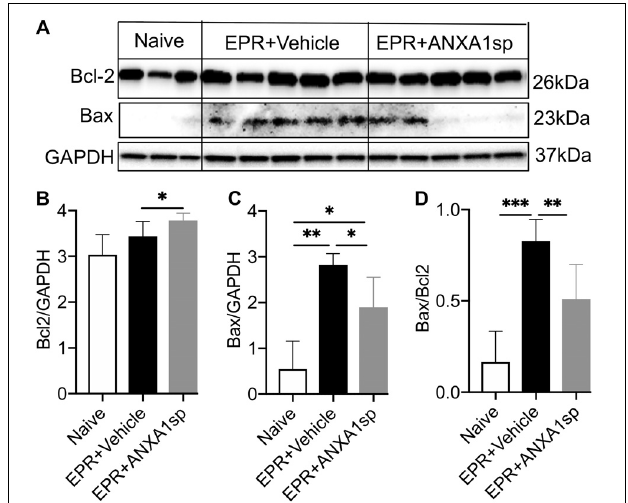
FIGURE 5 | Western blot analysis of cerebral Bcl-2 and Bax levels after exsanguination cardiac arrest/EPR and ANXA1sp or vehicle treatment. Intensities of protein bands corresponding to Bcl-2 (26 kDa) (A,B) and Bax (23 kDa) (A,C) were measured using computer assisted densitometric analysis, normalized to the intensity of GAPDH and compared between experimental groups. ANXA1sp treatment resulted in significantly increased expression of the anti-apoptotic protein Bcl-2 (B) , reduced expression of the pro-apoptotic protein Bax (C) , with a corresponding reduction in the Bcl-2:Bax ratio (D) . Data presented as mean ± SD ( n = 3–8/group), ∗ P < 0.05, ∗∗ P < 0.01, and ∗∗∗ P < 0.001 compared to either naïve or vehicle controls analyzed by one-way ANOVA with Tukey’s multiple comparisons test.